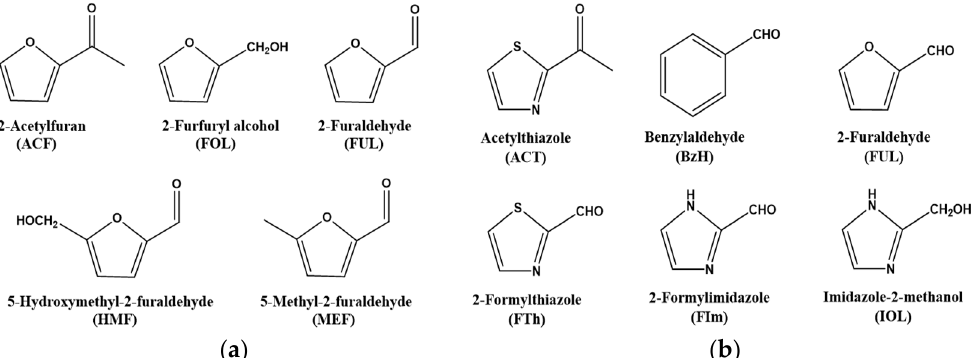
Figure 1. ( a ) Five furanic compounds and ( b ) six model templates used in this study.